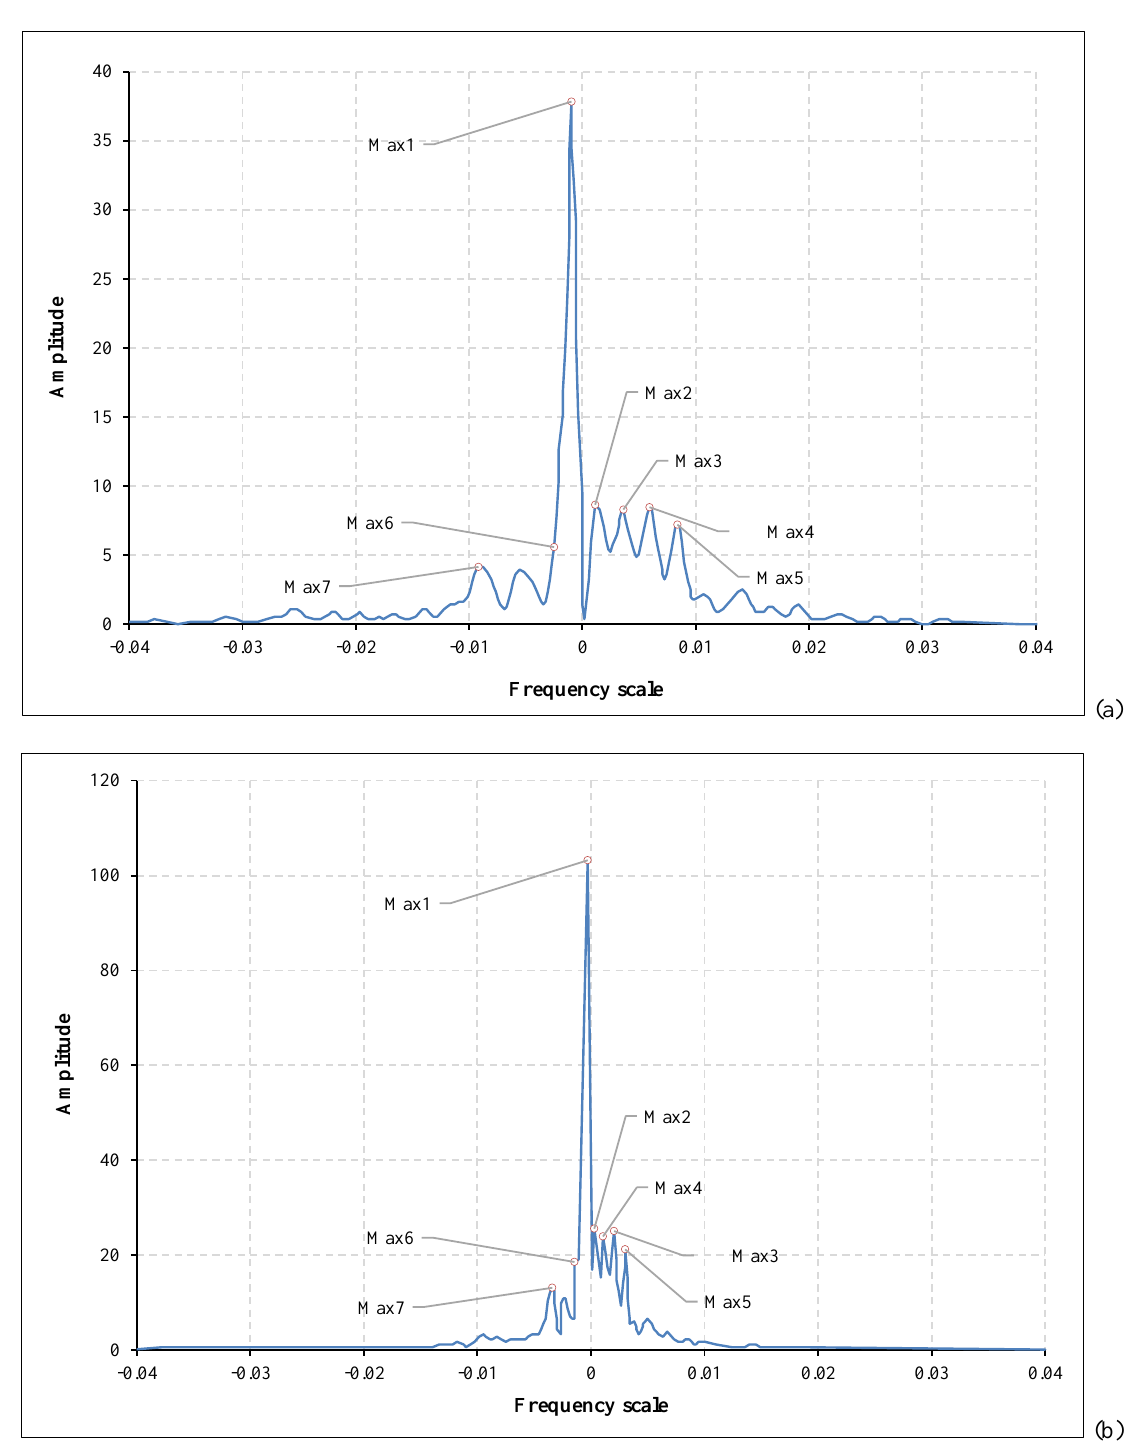
spectral components of the i -th contour with K max / K i when K max = 3000. Here, K i is the number of counts observed in the i -th contour. Figure 14 shows the spectra of the test contour before (a) and after the modification in the spectral domain (b).